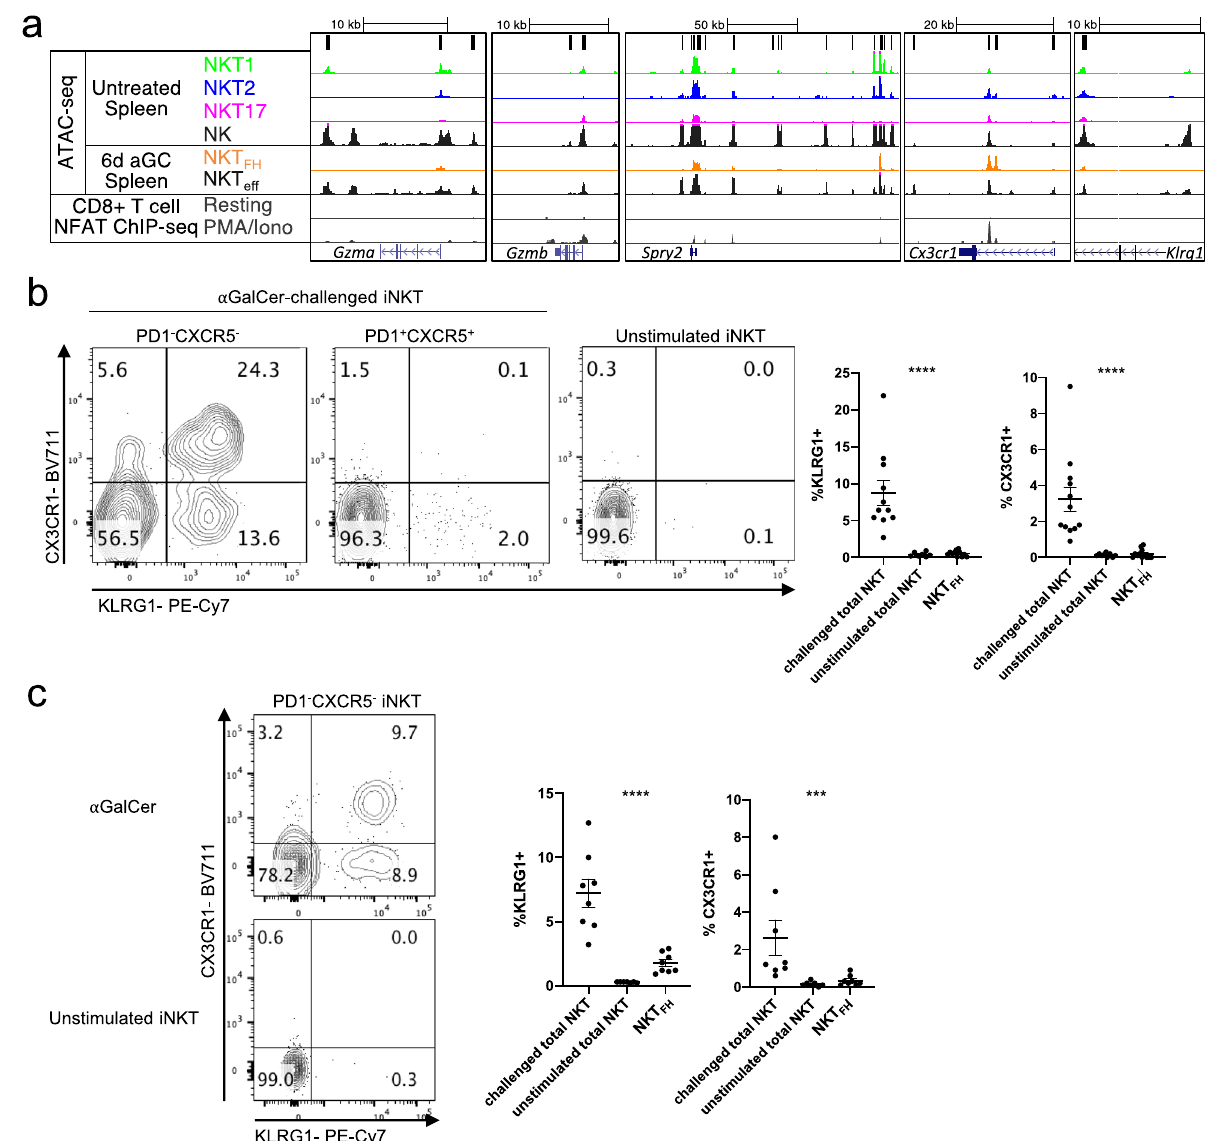
Fig. 6 Enhanced effector or NK cell signature in antigen-exposed iNKT cells. a ATAC-seq coverage (with a range of 0 – 600 for all samples) at the Gzma , Gzmb , and Spry2 loci comparing untreated splenic iNKT cells subsets, spleen NK cells, NKT FH , and NKT eff from mice injected 6 days earlier with α GalCer. NFAT1 ChIP-seq analysis of CD8 + T cells with and without PMA/ionomycin stimulation included for comparison 62 . b Flow cytometry analysis of expression of KLRG1 and CX3CR1 by the indicated populations of gated spleen iNKT cells at day 6 after antigen. Quanti fi cation on right, n = 11 mice ( α GalCer challenged, KLRG1), n = 12 mice ( α GalCer challenged, CXCR3), n = 6 mice (unstimulated, KLRG1), n = 8 mice (unstimulated, CXCR3), n = 11 – 12 mice (NKT FH ). c (Left) Representative fl ow cytometry analysis of expression of NKT eff markers CX3CR1 and KLRG1 by spleen PD-1 – KLRG1 – iNKT cells at day 30 or later after antigen administration. (Right) Quanti fi cation of iNKT cells expressing NKT eff markers, challenged mice analyzed at day 30 or later. n = 8 mice ( α GalCer challenged, NKT FH ), n = 7 mice (unstimulated). b , c Representative data from 3 – 5 experiments, error bars depict mean and SEM, statistical signi fi cance (*** = p of 0.005, **** = p < 0.0001) assessed via Kruskal – Wallis